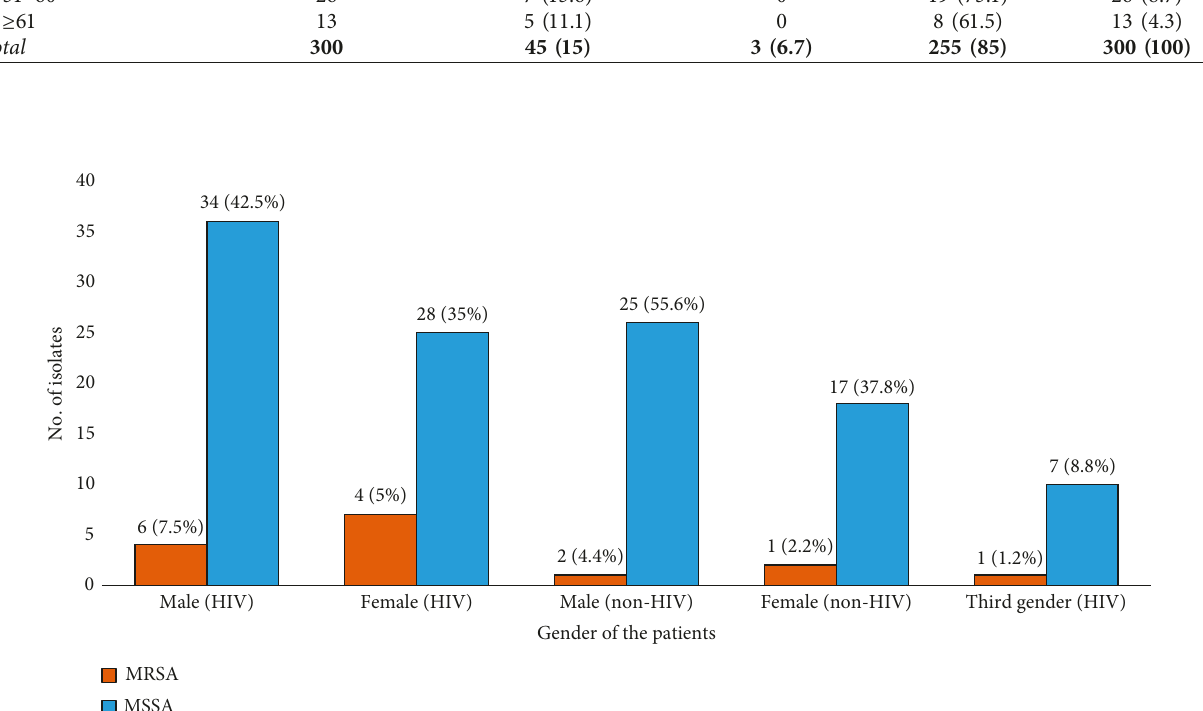
Figure 1: Gender-wise distribution of MRSA and MSSA isolates among HIV-infected and non-HIV